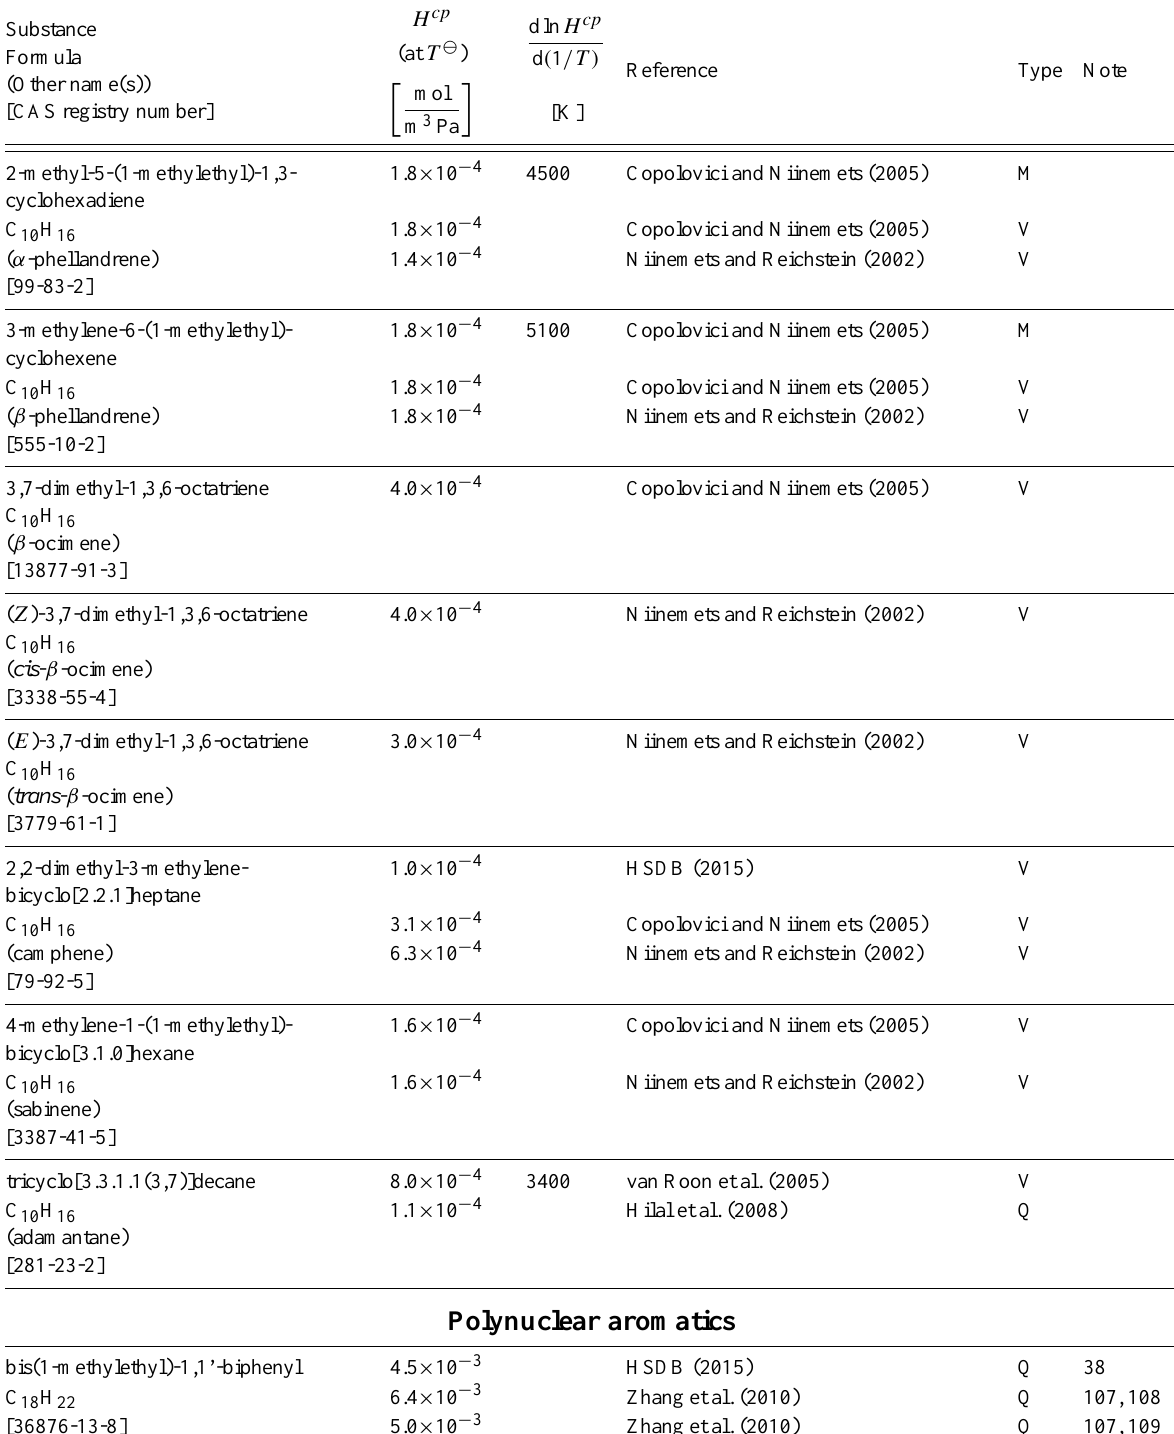
Table 6: Henry’s law constants for water as solvent